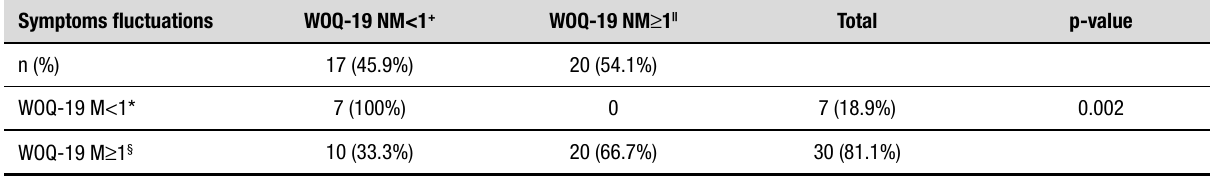
Table 4. Frequency of motor symptoms and non-motor symptoms fluctuations. Symptoms